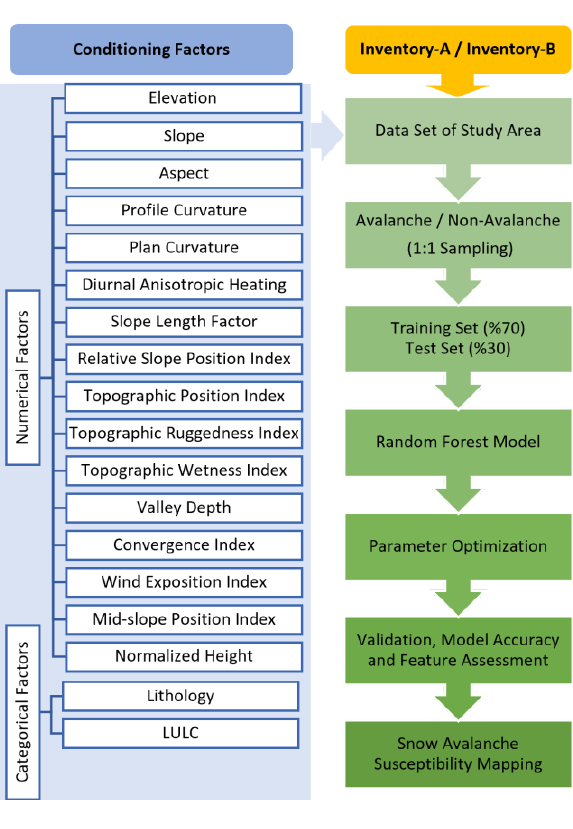
Table 1. The pixel counts of snow avalanche inventories.